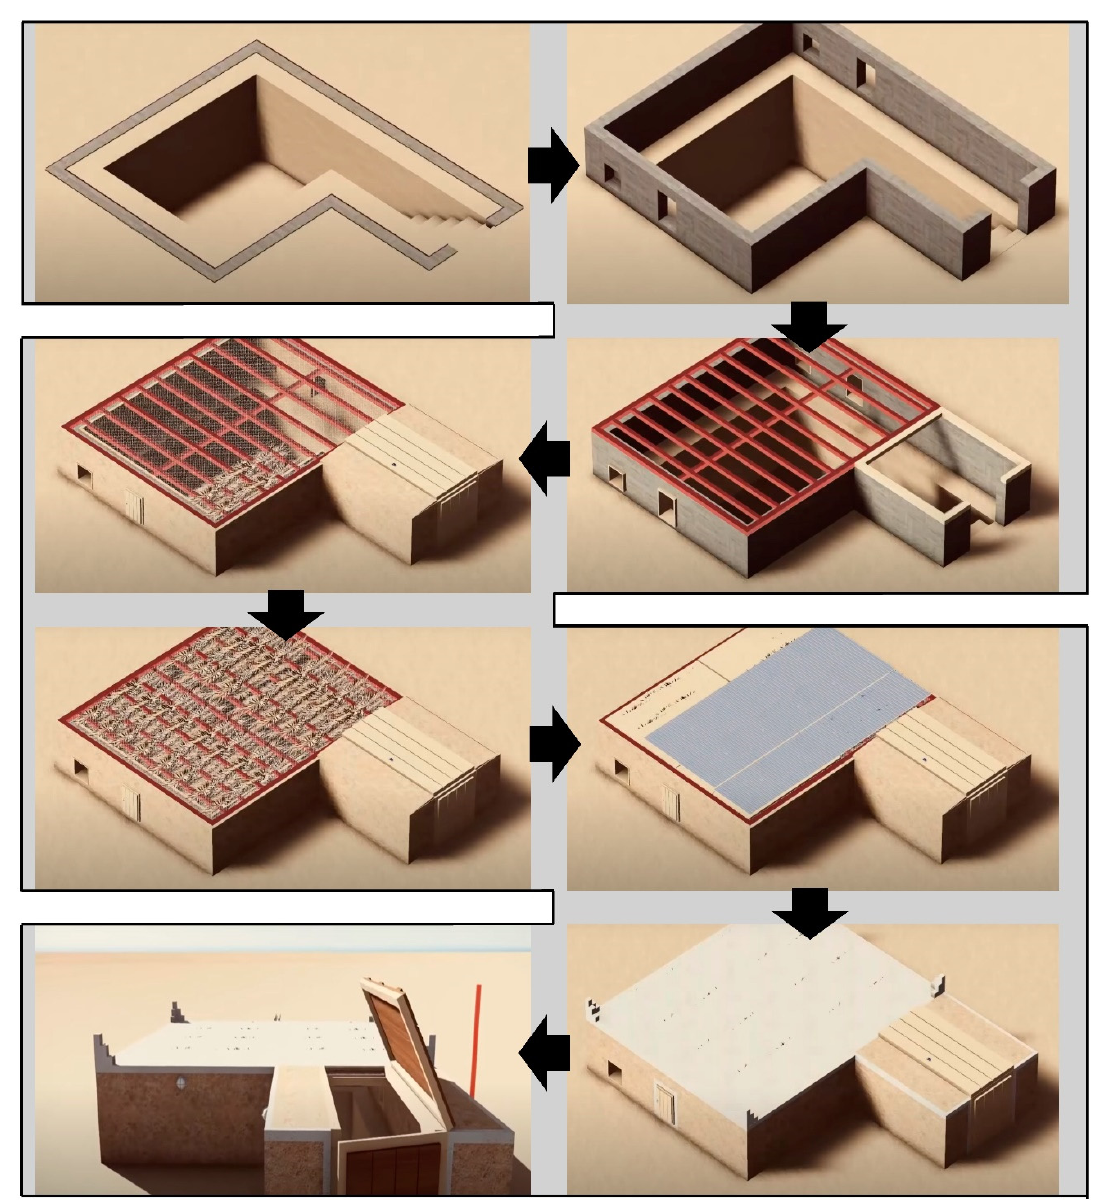
Figure 3. Process of building the underground model, designed by (Mohammed Al-Amoodi).